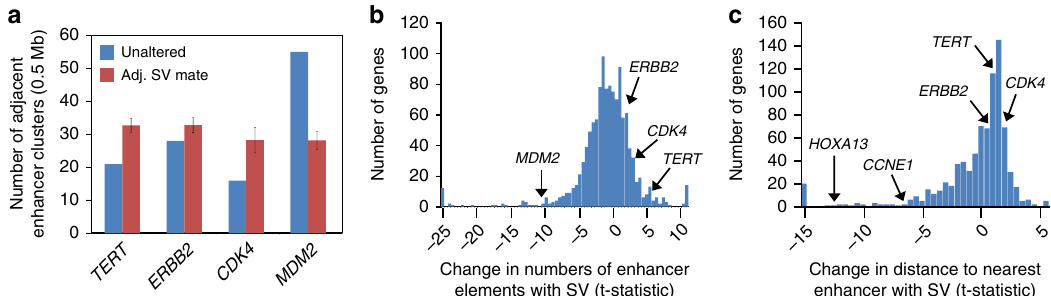
Fig. 5 Translocation of enhancer elements associated with SV breakpoints near genes. a For TERT , ERBB2 , CDK4 , and MDM2 , average number of enhancer elements within a 0.5 Mb region upstream of each rearrangement breakpoint (considering the respective SV sets occurring 0 – 20 kb upstream of each gene), as compared with the number of enhancers for the unaltered gene. All differences are signi fi cant with p < 0.01 (paired t -test). Error bars denote standard error. b For 1233 genes with at least 7 SV breakpoints 0 – 20 kb upstream and with breakpoint mate on the distal side from the gene, histogram of t -statistics (paired t -test) comparing numbers of enhancer elements 0.5 Mb region upstream of rearrangement breakpoints with the number for the unaltered gene. Positive versus negative t -statistics denote greater versus fewer enhancers, respectively, associated with the SVs. c For 829 genes (with at least 5 SV breakpoints 0 – 20 kb upstream and with breakpoint mate on the distal side from the gene, where the breakpoint occurs between the gene start site and its nearest enhancer in the unaltered scenario), histogram of t -statistics (paired t -test) comparing the distance of the closest enhancer element upstream of rearrangement breakpoints with the distance for the unaltered gene. Negative t -statistics denote a shorter distance associated with the SV breakpoints. See also Supplementary Data